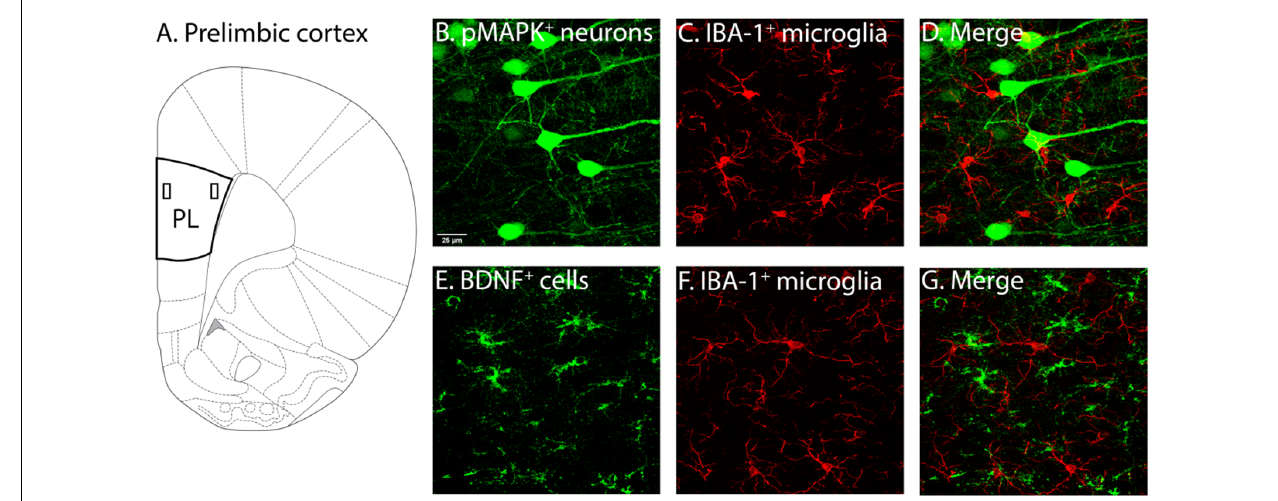
FIGURE 2 | Illustration of PL and associated labelling in this region. (A) Two layers of the PL were of interest, layers 2–3 (demarcated by the rectangle closer to the border) and layers 5–6 (demarcated by the rectangle further from the border). Following identification of PL layers 2–3 and 5–6 (Miner et al., 2003; Perez-Cruz et al., 2007) used as guides, pMAPK expressing neurons (B) , BDNF expressing cells (E) and IBA-1 (C–F) labelled microglia, as well as their co-localisation (D–G) were quantified. PL, pre-limbic cortex; pMAPK, phosphorylated mitogen-activated protein kinase; BDNF, brain-derived neurotrophic factor; IBA-1, ionized calcium-binding adaptor molecule